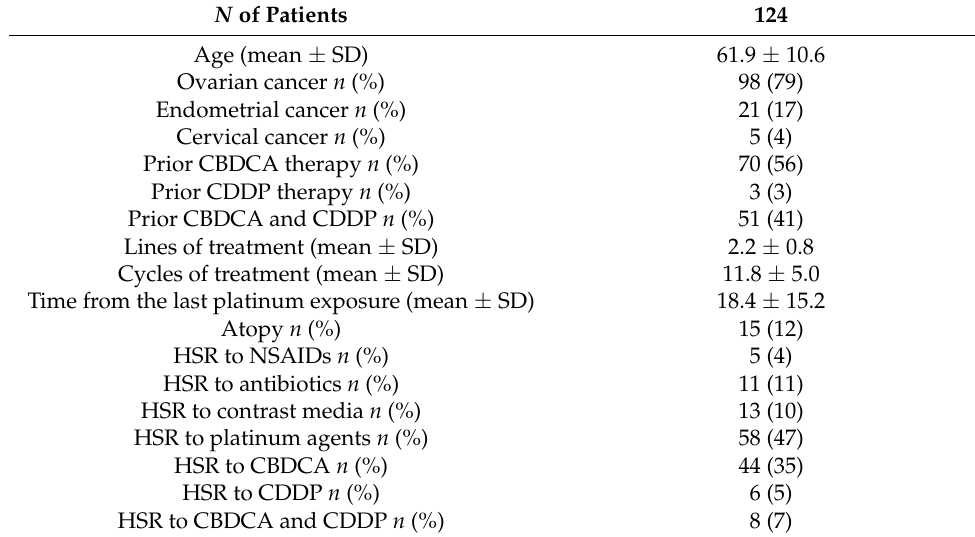
Table 1. Patients (cid:48) characteristics.